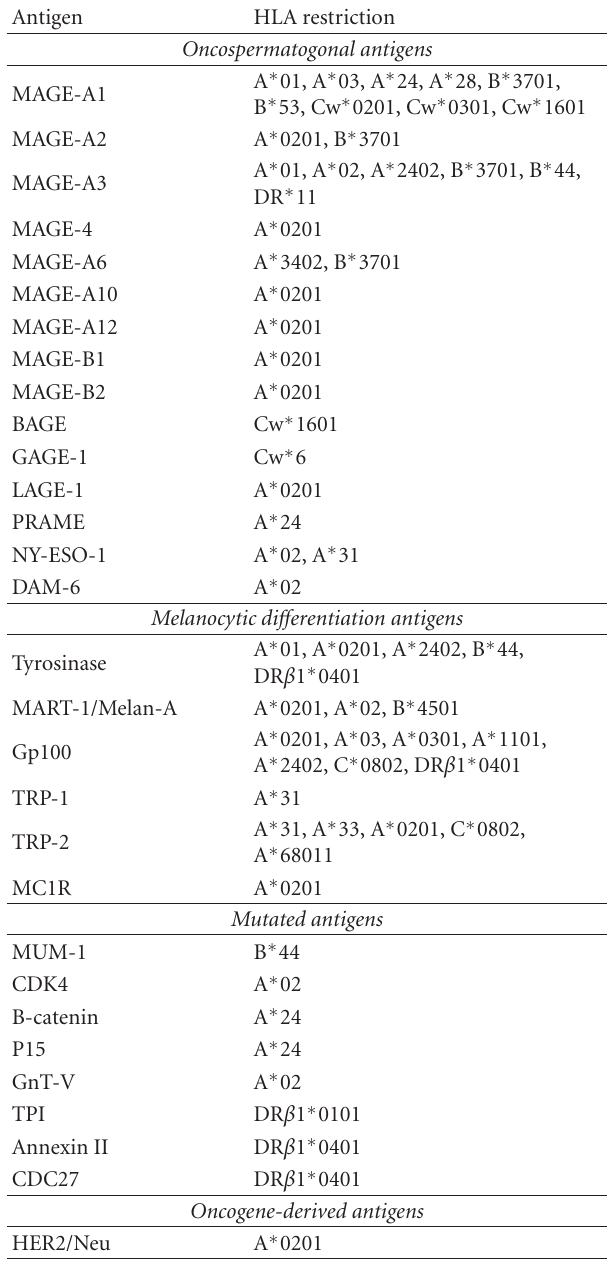
Table 1: Melanoma-associated antigens (adapted from Visser et al.